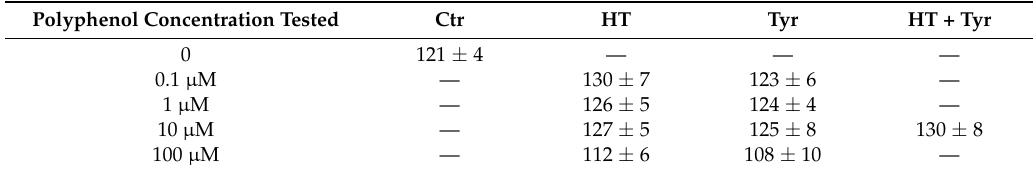
Table 4. Endothelial cell number in response to polyphenols alone or in combination during 48 h